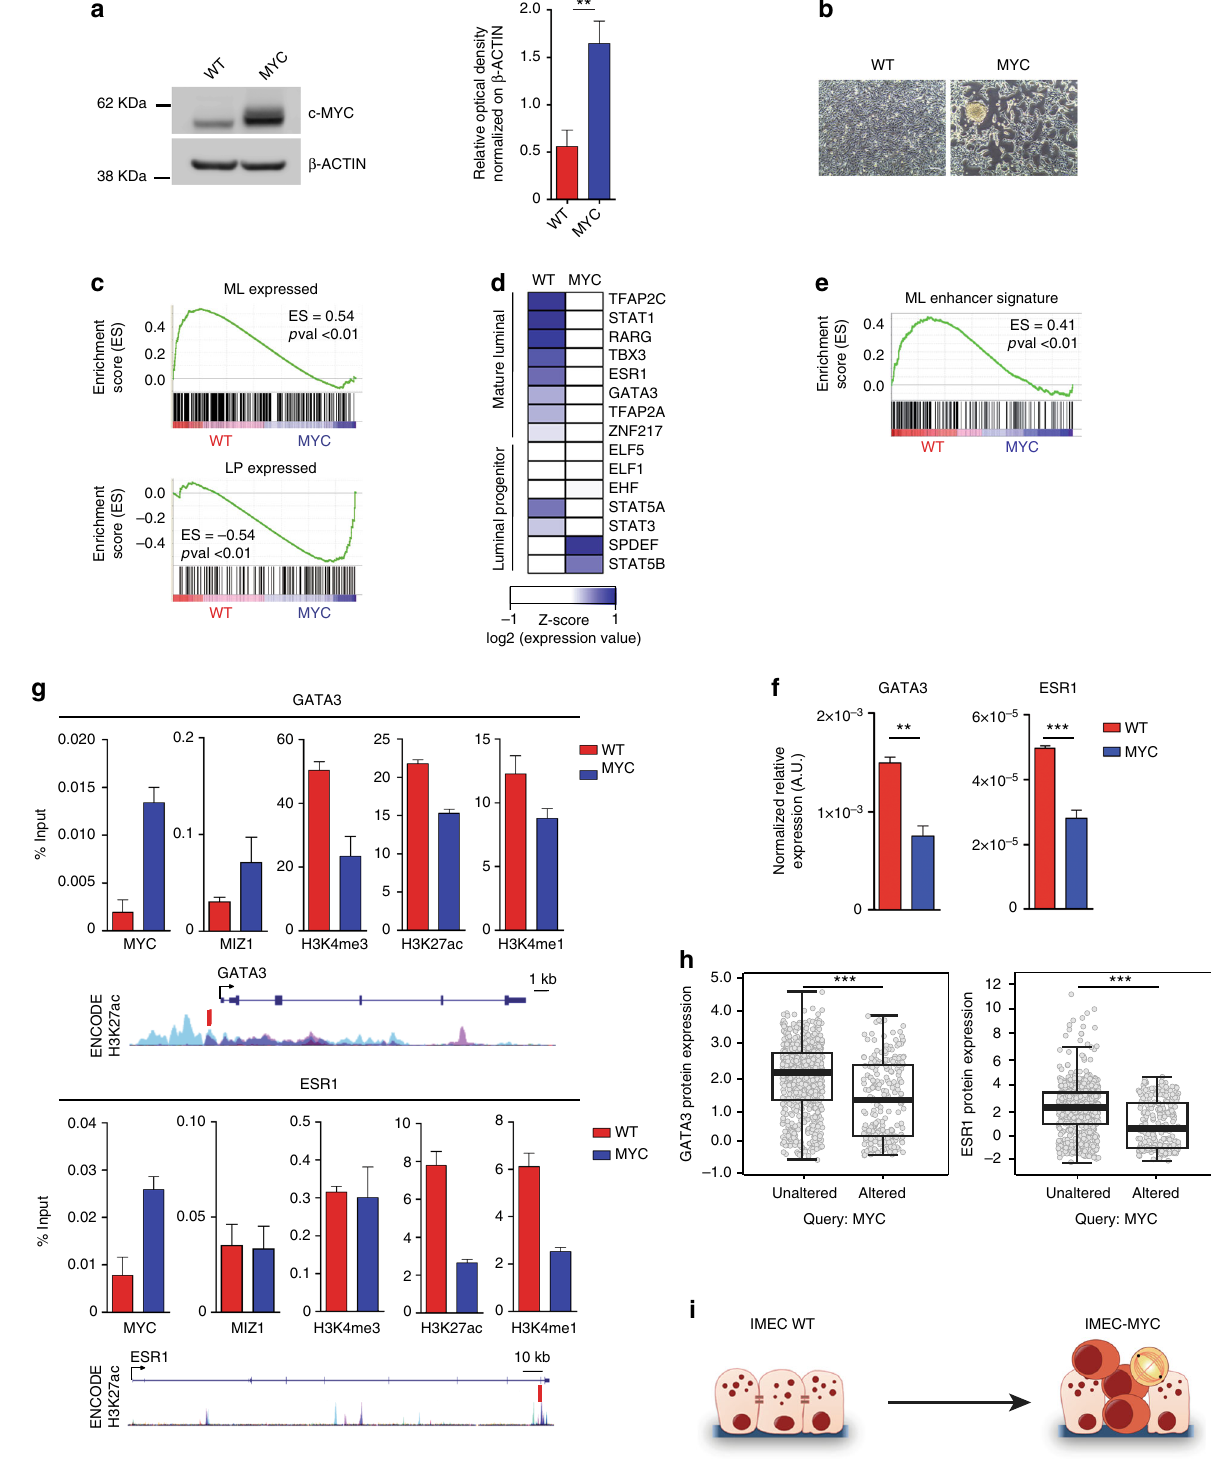
Fig. 1 MYC inhibits the transcriptional program of mature luminal epithelial cells. a Western blot of c-MYC in IMEC WT and IMEC-MYC; β -ACTIN was used as loading control. Signal quanti fi cation is reported. Data are means ± SEM ( n = 3). (** P < 0.01; Student ’ s t- test). b Phase contrast images of con fl uent IMEC WT and IMEC-MYC. Scale bar, 200 µ m. c GSEA of mature luminal (ML) and luminal progenitor (LP) gene signatures in IMEC WT vs. IMEC-MYC ( n = 3). d Heatmap showing the expression of luminal specifying TFs in IMEC WT and IMEC-MYC. e GSEA of genes regulated by enhancers bound by mature luminal-speci fi c TFs in IMEC WT vs. IMEC-MYC ( n = 3). f qRT-PCR of GATA3 and ESR1 in IMEC WT and IMEC-MYC, normalized on spike-in RNAs. Data are means± SEM ( n = 3). (** P < 0.01, *** P < 0.001; Student ’ s t- test). g ChIP-qPCR assessing MYC and MIZ1 binding and H3K4me3, H3K27ac, and H3K4me1 deposition at GATA3 promoter and ESR1 intronic enhancer in IMEC WT and IMEC-MYC. A scheme showing GATA3 and ESR1 PCR amplicons localization (red boxes) and layered H3K27ac signals from ENCODE is represented. Data are means ± SEM ( n = 3). h Box plots representing the protein levels of GATA3 (left panel) and ESR1 (right panel) in breast cancer samples with unaltered or altered MYC level. i Scheme showing the MYC-induced reprogramming of IMEC WT to the luminal progenitor-like state of